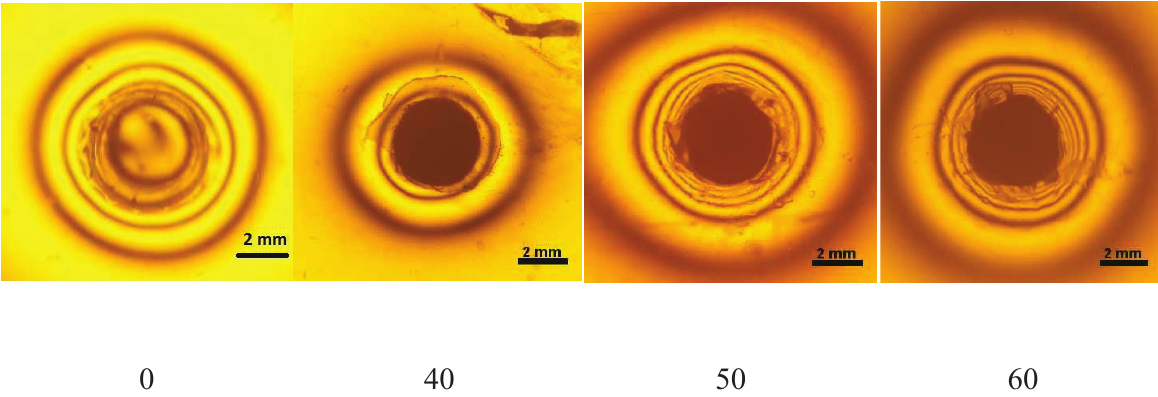
Figure 4: The influence of filler amount on diametral tensile strength (DTS) of neat resin and composite filled with 40, 50 or 60 wt. % silanized silica; photopolymerization conditions - 20 second/1 mm material thickness, the power of light curing unit 1400 mW/cm 2 .